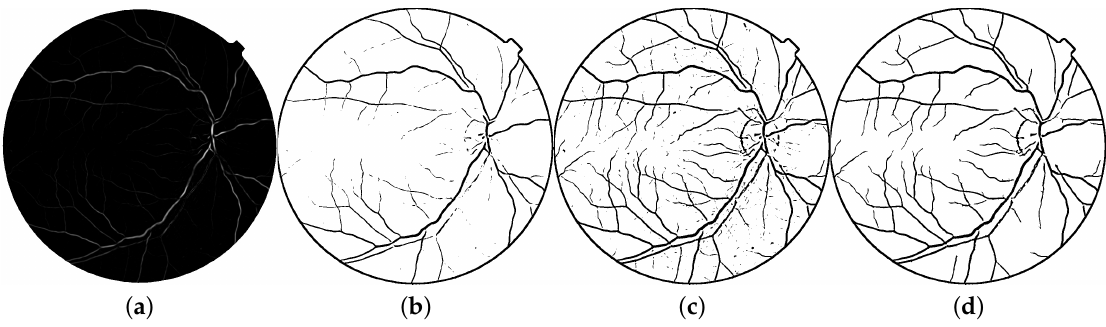
Figure 8. Blood vessels detection: ( a ) response of the Frangi filter, ( b ) Kittler thresholding, and segmentation using ( c ) a fixed threshold T = 0.01 and ( d ) a fixed threshold T = 0.01 and a length filter of 100 pixels, | ¯ V l | =